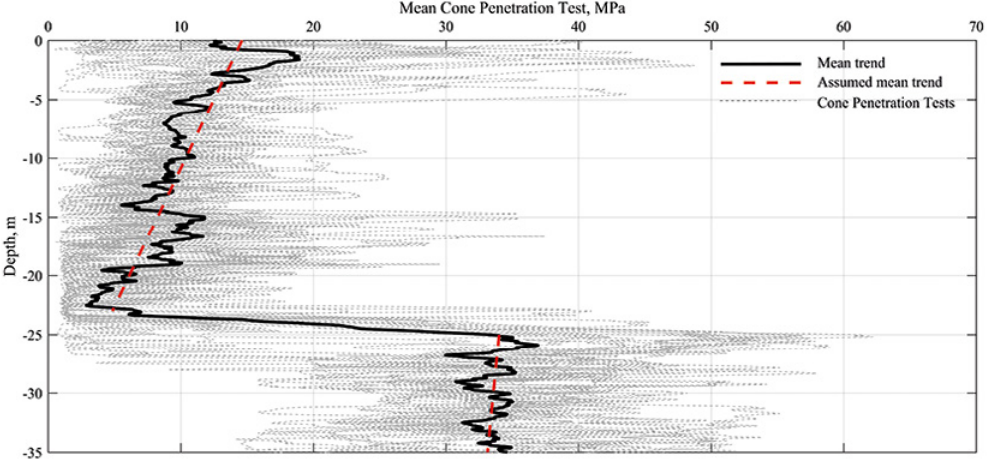
Figure 3. Example of Cone Penetration Test data and inherent variability across a